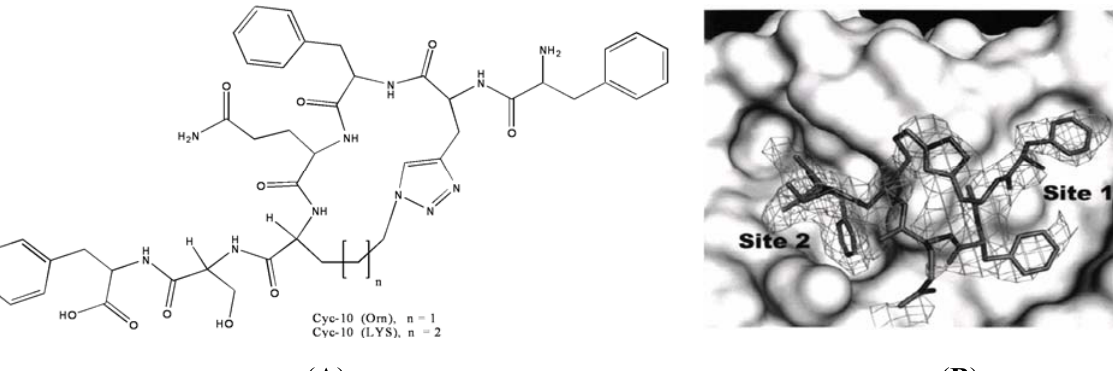
Figure 10. Cyc 10 ( A ) Cyc 10 structure ( B ) Mode of binding of Cyc 10 to